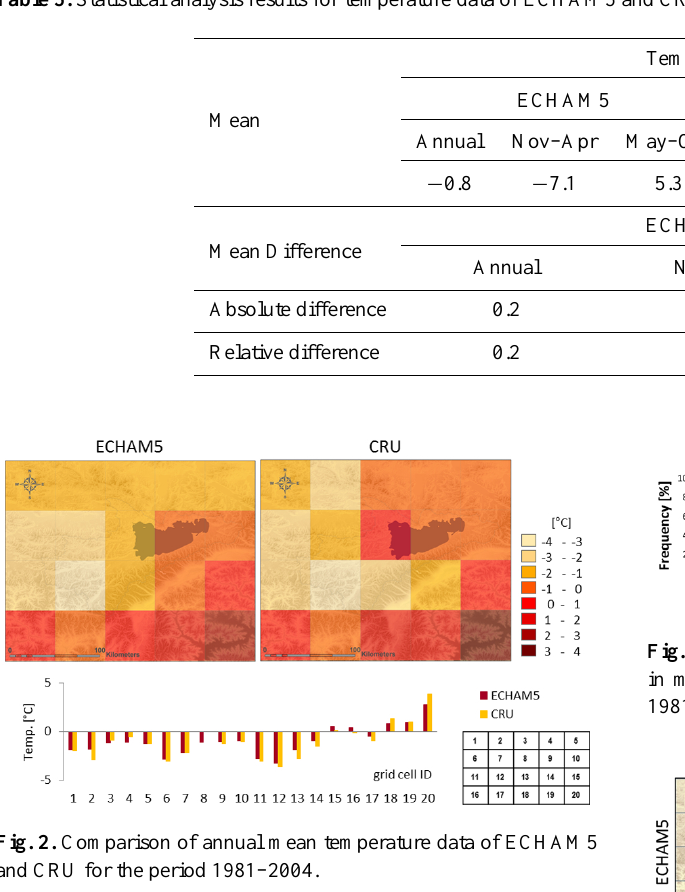
Table 5. Statistical analysis results for temperature data of ECHAM5 and CRU for the period 1981–2004.